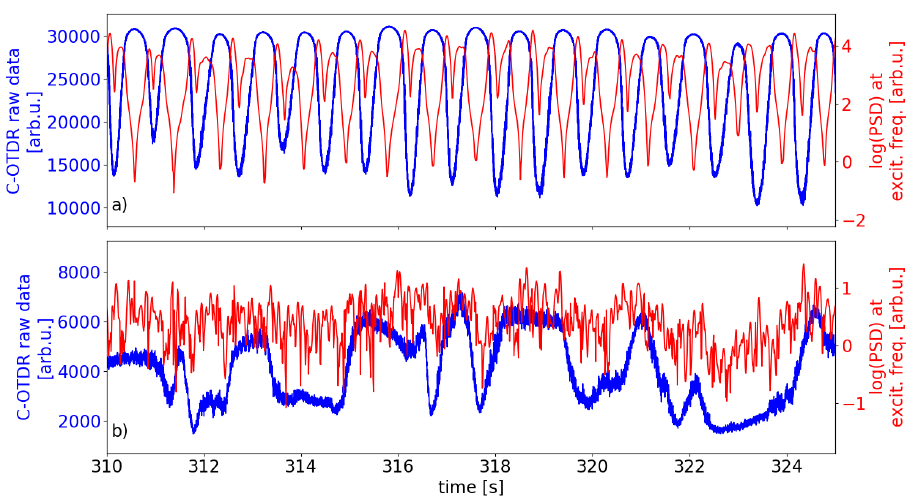
Figure 7. Intensity dynamics and current signal strength during ongoing heating process: timeseries of C-OTDR raw data (blue) in single sensor bin and corresponding log PSD at excitation frequency f = 700 Hz (red) over time. ( a ) sensor bin at sensitivity maximum within modified segment of fiber ( b ) sensor bin in unmodified segment of